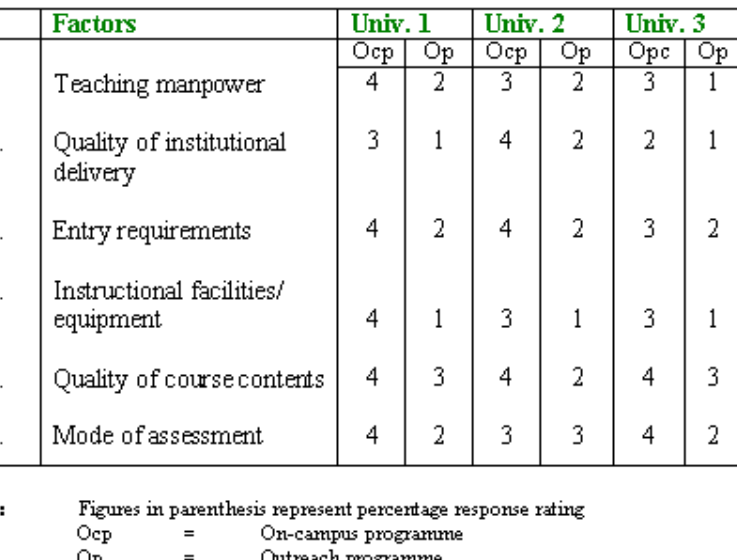
Table 2. Rating of Academic Performance induced Factors Based on NUC Minimum Standards (Level of